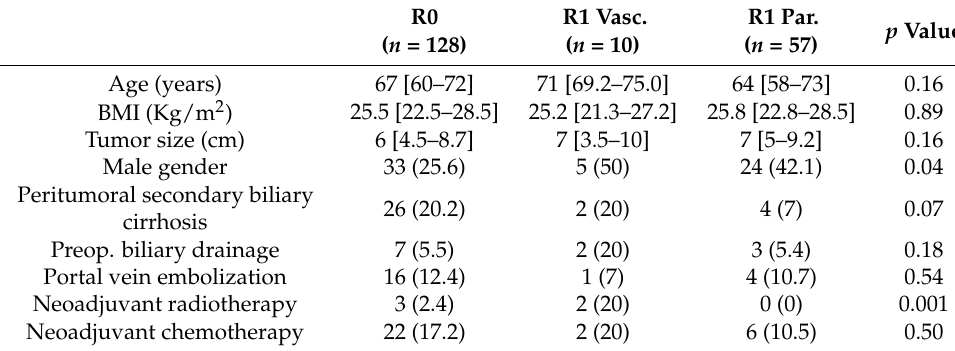
Table 1. Preoperative features according to R